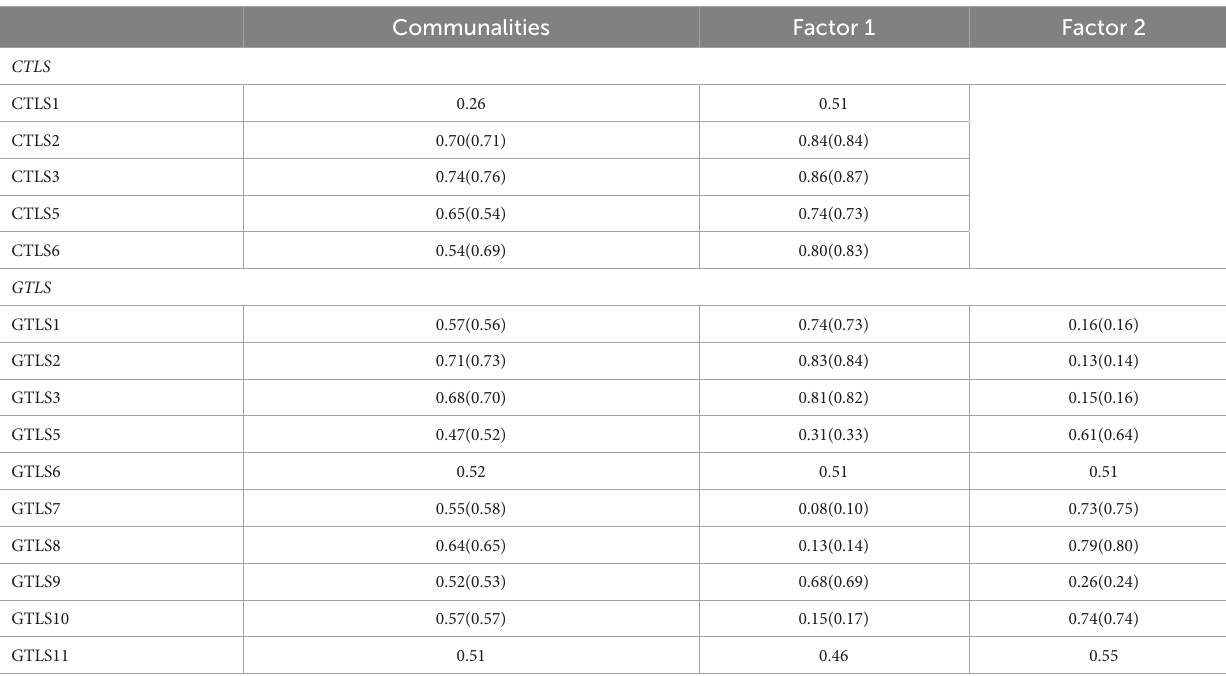
TABLE 2 Exploratory factor analysis ( N =